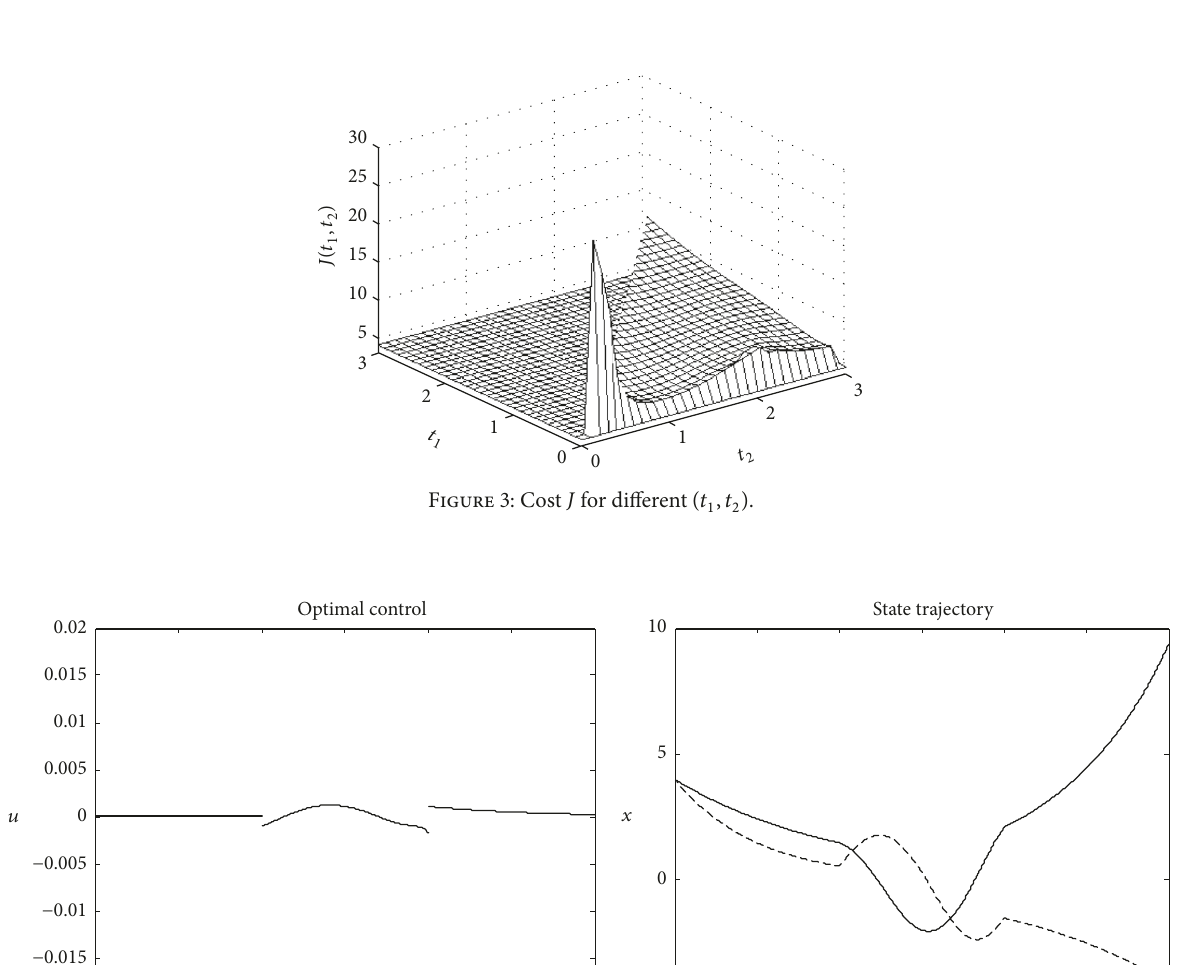
Figure 2: Continuous control input and optimal state trajectory.